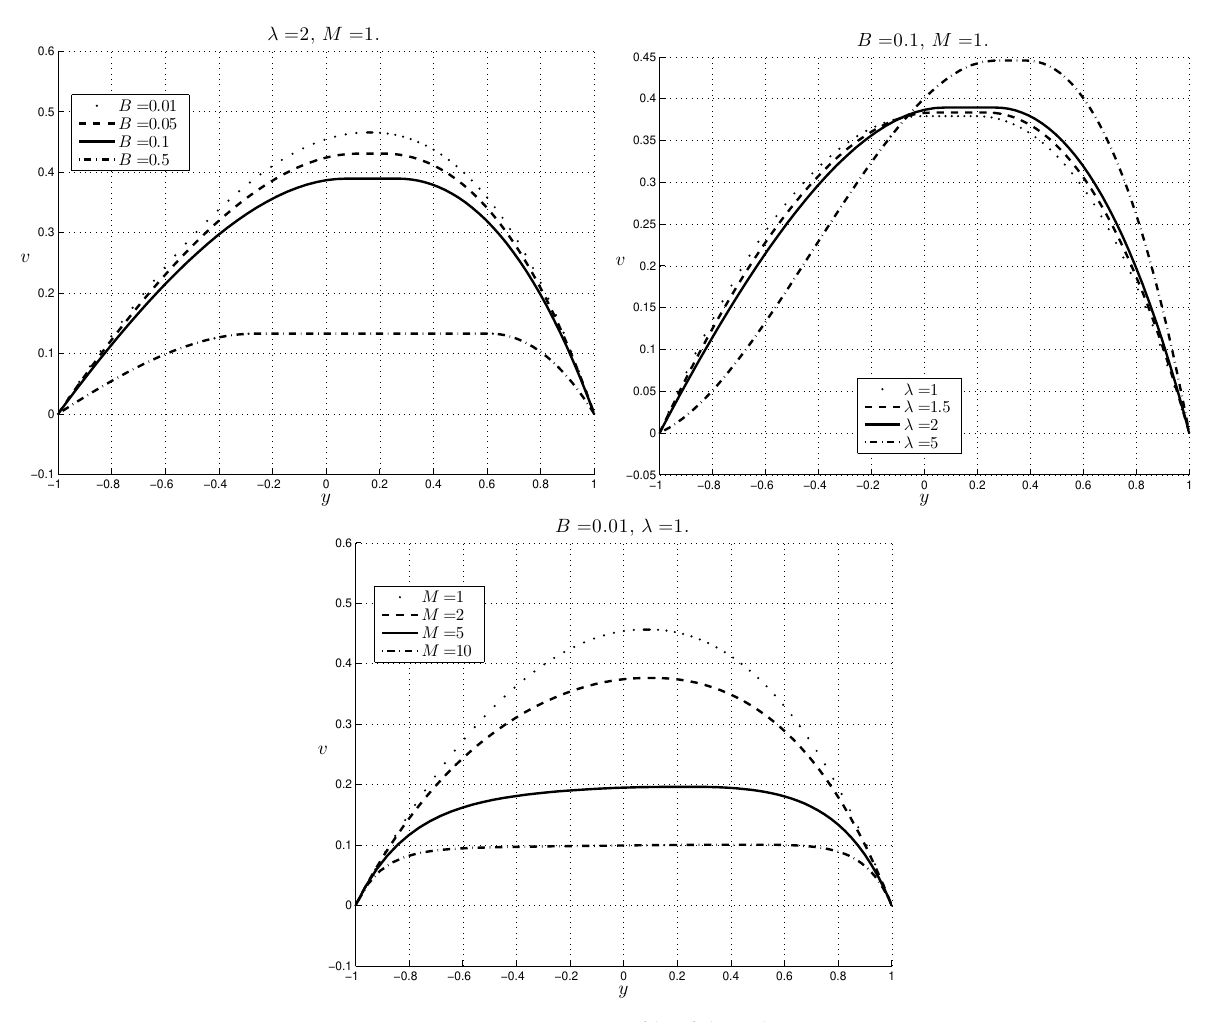
Figure 14. Case 1M : profile of the velocity.